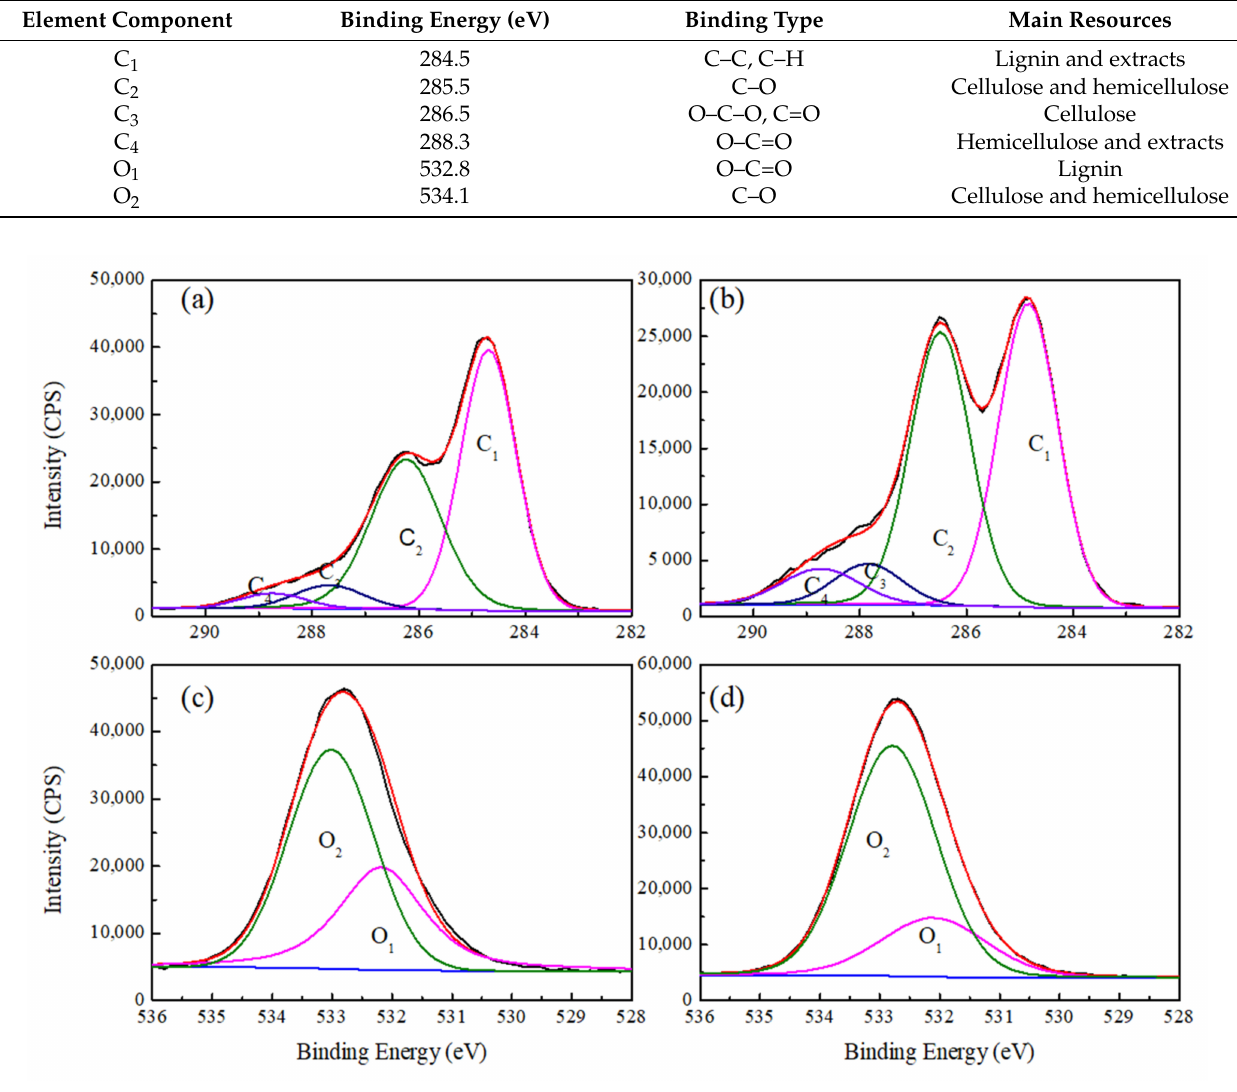
Figure 3. High-resolution X-ray photoelectron spectroscopy (XPS) spectra of ( a , b ) carbon and